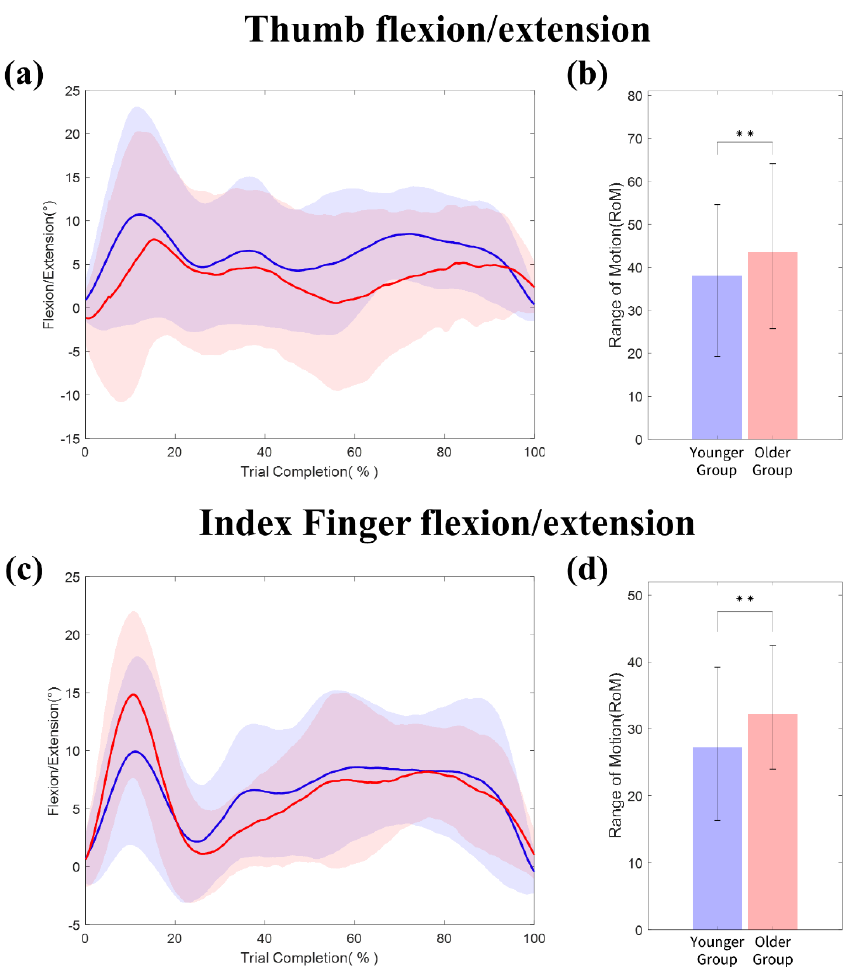
Figure 7. Kinematic trajectories and the RoM of the thumb and index finger for the younger (blue) and older adults (red): ( a ) the thumb and ( c ) index finger of the flexion/extension trajectories by age and ( b ) the thumb and ( d ) index finger flexion/extension RoM by age. Finger movements : Figure 7a,c show the kinematic trajectories for flexion/extension of the thumb and index finger. In initial object grasping, the thumb and index finger flexion markedly